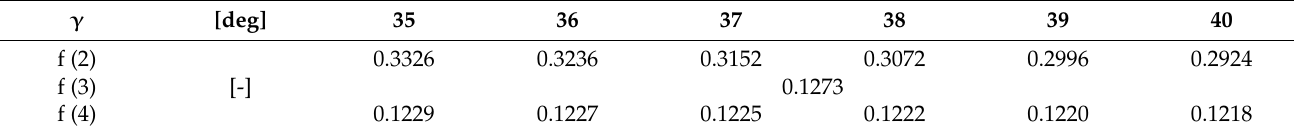
Table 1. Coefficient of friction in the pulley groove.